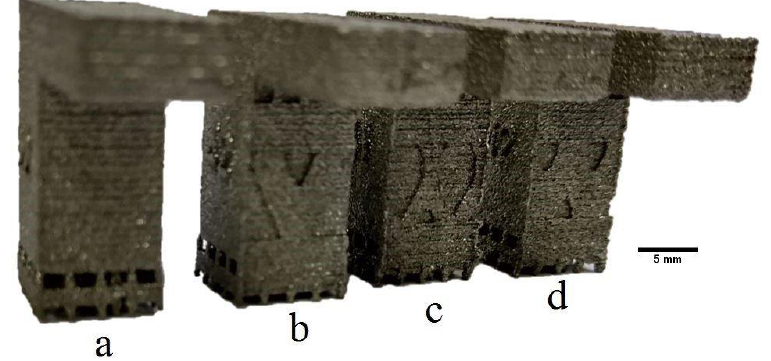
Figure 4. Overhang side surface quality: ( a ) No support offset; ( b – d ) layers of support adhesion on the overhang wall.